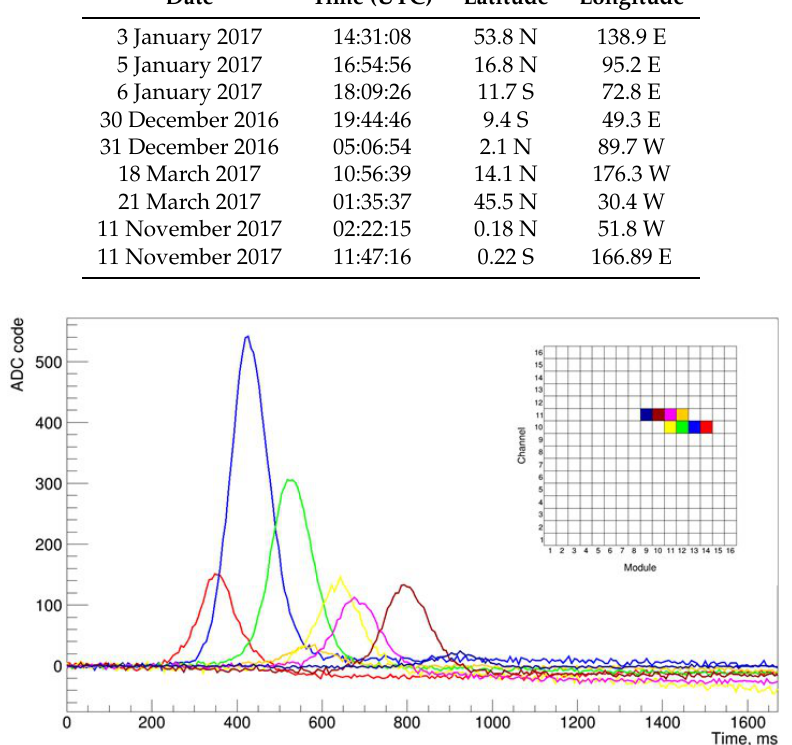
Figure 13. Waveforms of a few hit pixels of the meteor measured on 3 January 2017 at 14:31:08